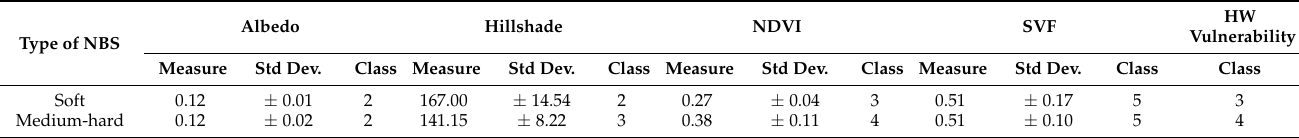
Table 8. Results of NBSs typological